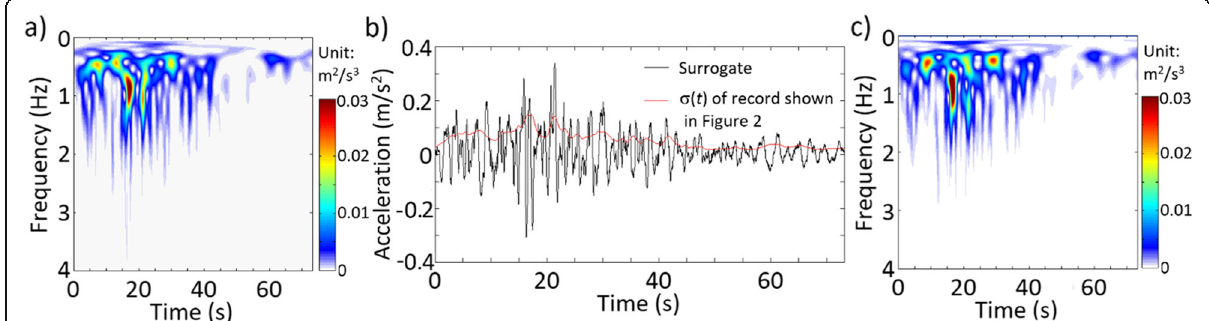
Fig. 3 Results by using ST for the given record shown in Fig. 2: a TFPSD of the given record, b a generated surrogate and σ ( t ) of the given record, and c TFPSD of the generated surrogate shown in Fig. 3b